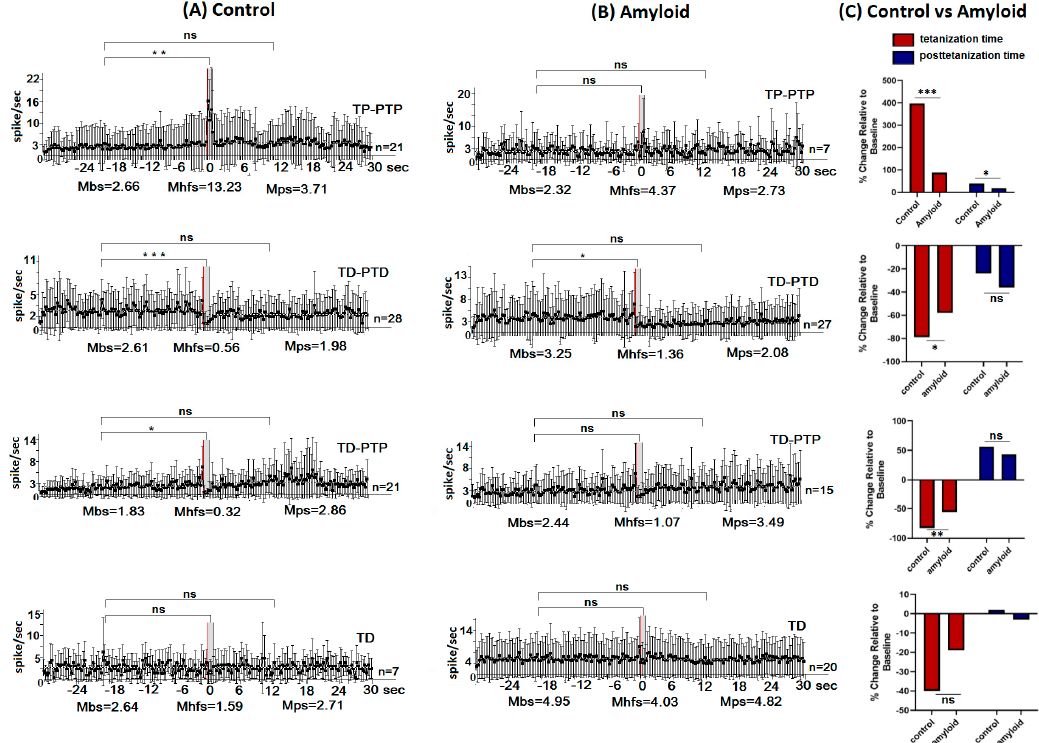
Figure 3. The average peri-stimulus time histogram of spike frequency in amygdale neurons. ( A , B ). The mean peri-stimulus frequency diagrams built on the basis of pre-stimulus and post-stimulus manifestations of spike activity of single amygdala neurons to high-frequency stimulation of nucleus basalis magnocellularis in a real-time 30 s before stimulation (Mbs), 30 s post-stimulation (Mps) and during high-frequency stimulation (Mhfs) exhibiting the specified type of responses (TP-PTP, TD-PTD, TD-PTP, TD) in the control ( A ) and amyloid ( B ) groups. The data are presented as mean ± SD; n = number of neurons. The statistical significance of a difference from baseline (Mbs) was estimated according to the unpaired Student’s t-test, * p < 0.05, ** p < 0.01, and *** p < 0.001 ( C ). The bar diagrams show the average % changes relative to baseline (Mbs, zero level) in responses of tetanization time (red) and post-tetanization time (blue) in the control vs. amyloid groups in the population of neurons with a given type of response. Statistical significance was calculated using Fisher’s exact test, * p < 0.05, ** p < 0.01, and *** p < 0.001.